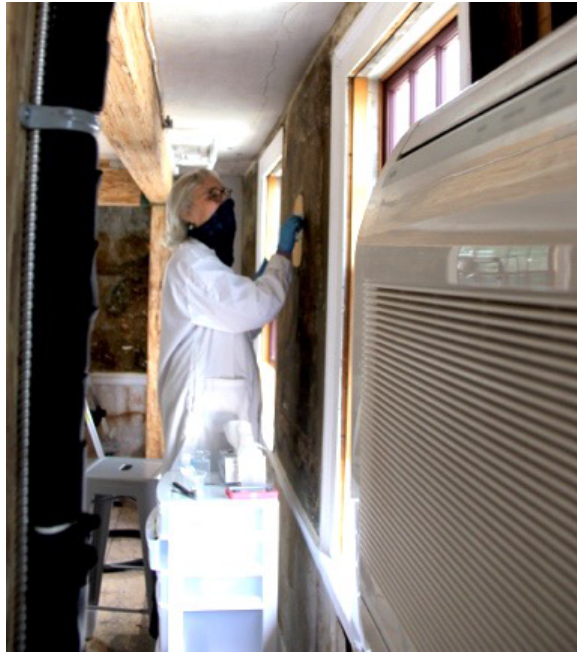
Figure 7: Conservator working next to AHS-installed environmental control